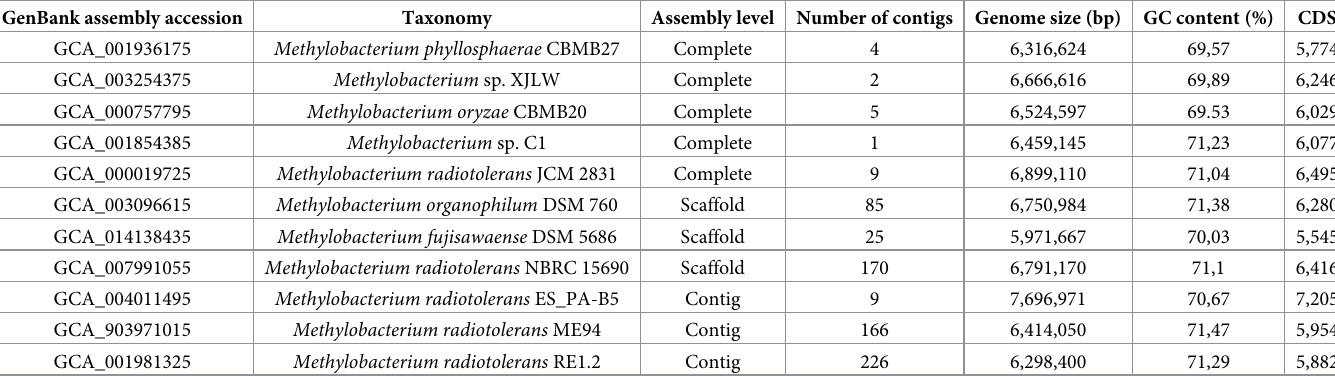
Table 1. Reference genomes used for comparative genomic